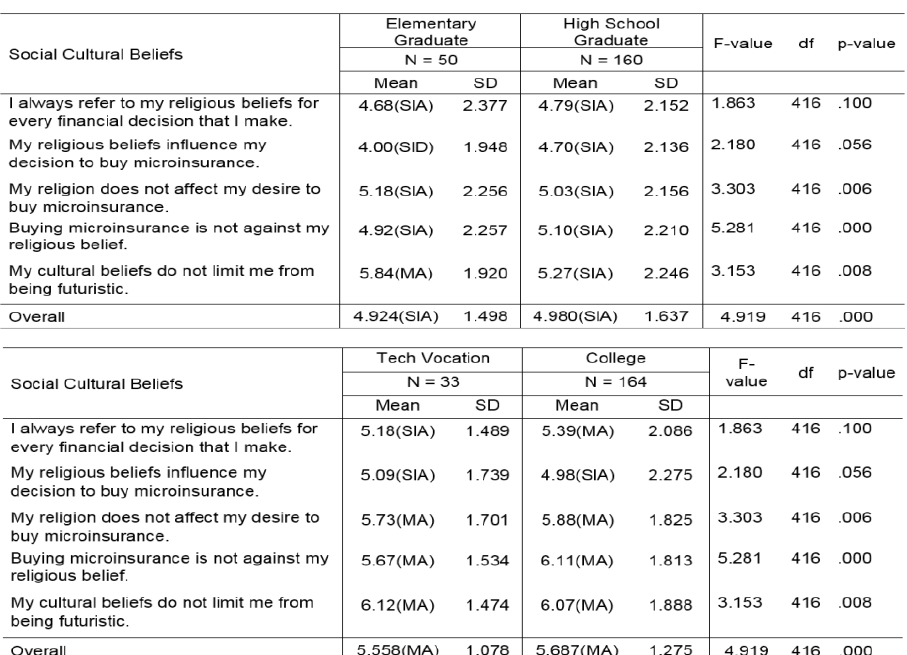
Table 3: Level of Agreement of the Respondents on the Social Cultural Beliefs on Microinsurance According to